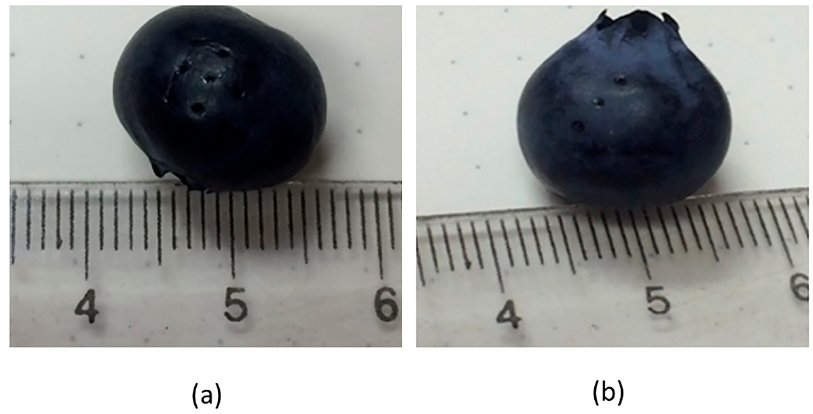
Figure 9. Appearance of blueberry fruit with nine (a) and three (b) CO 2 laser microperforations.